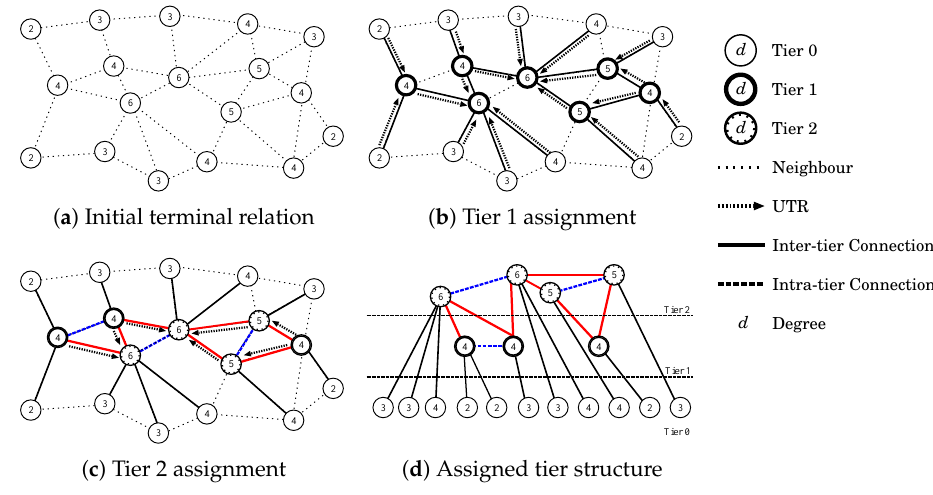
Figure 1. Tier assignment in VORTEX.